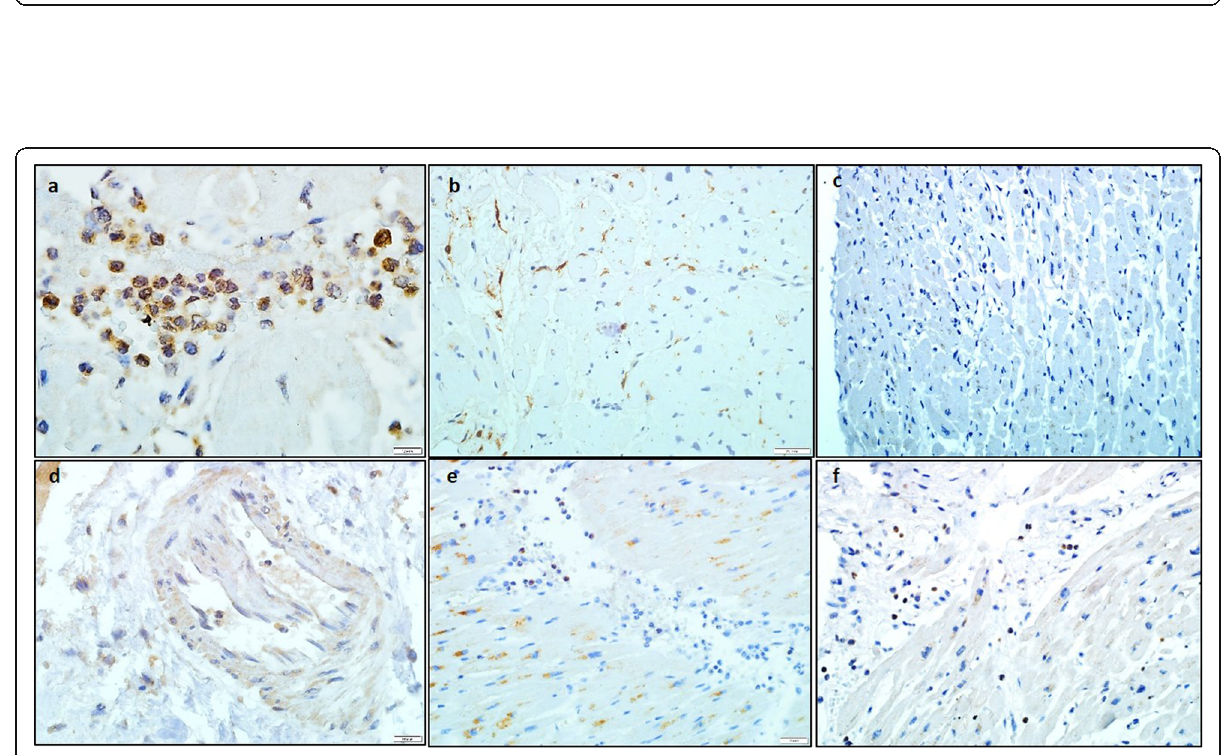
Fig. 1 Histological characteristics of myocarditis in COVID-19. a,b - cardiomyocyte degeneration, diffuse lymphocytic infiltration in myocardium stroma; c,d - destructive productive coronaritis with intravascular thrombosis of small branches, e - degranulation of mast cells in myocardial stroma, f - lymphocytic endocarditis, g - lymphocytic pericarditis. Staining by hematoxylin and eosin (a-d,f,g) and toluidin blue (e), magnification × 600 (a,e,f,g), × 200 (b,c,d)